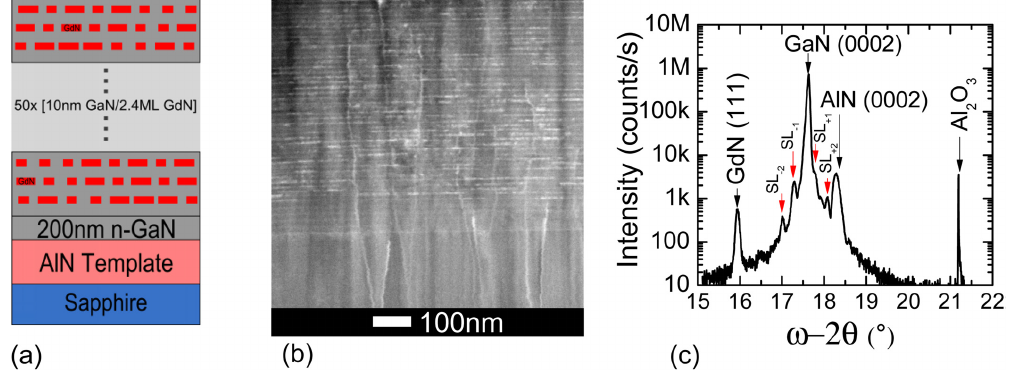
Figure 16. GdN nanoislands embedded in a GaN/GdN superlattice. ( a ) Sample structure, ( b ) cross-section high angle annular dark-field scanning TEM of the superlattice structure, and ( c ) HRXRD showing the orientation of the GdN embedded nanoislands in the GaN matrix. Reproduced with permission from Reference